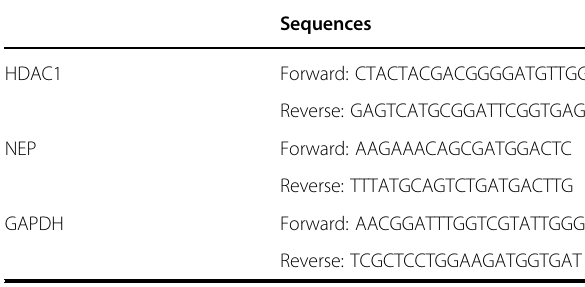
Table 1 Primer sequences for reverse transcription quantitative polymerase chain